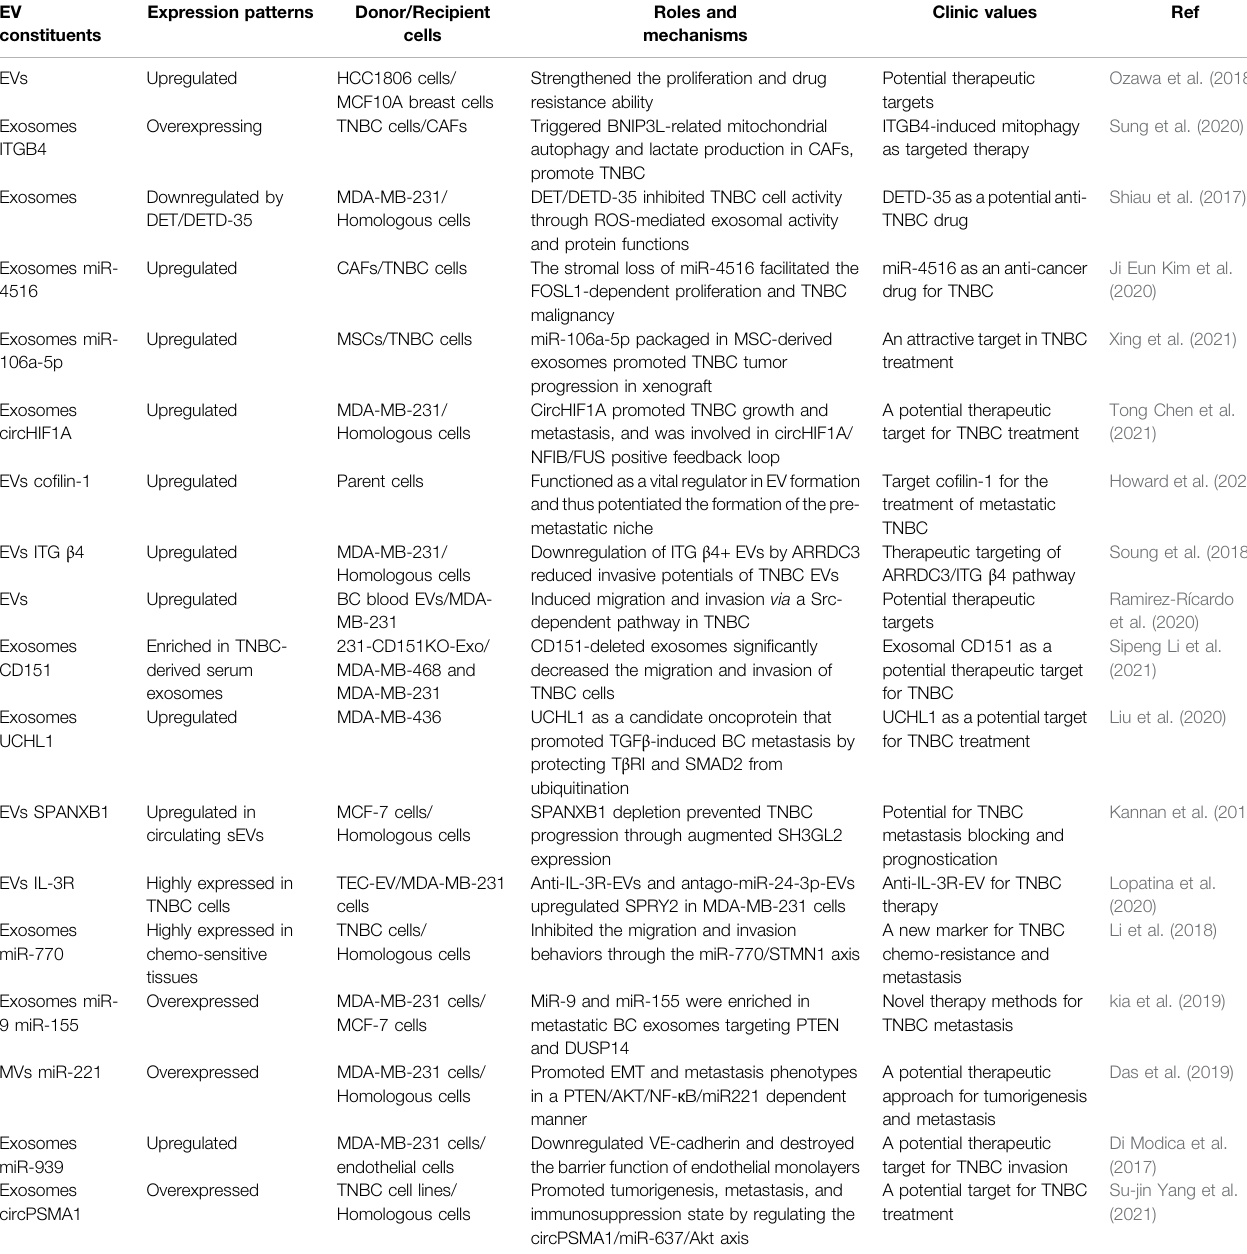
TABLE 1 | EVs and their constituents in remodeling TNBC